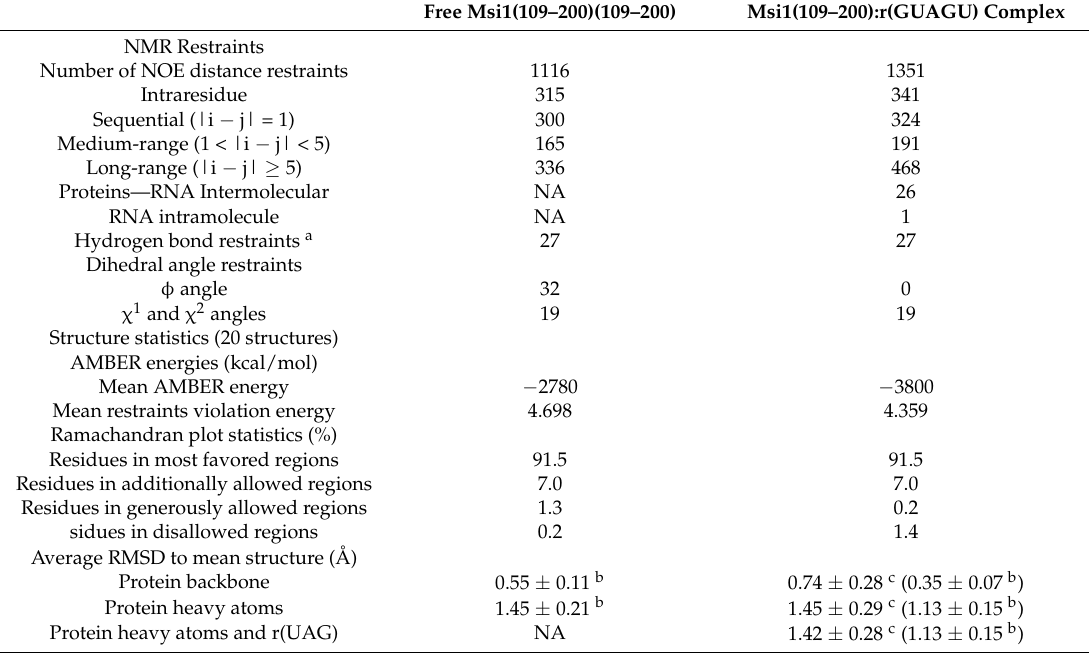
Table 1. Structural statistics for Msi1(109–200) in the free and r(GUAGU)-bound forms. (Abbreviation; NA: not